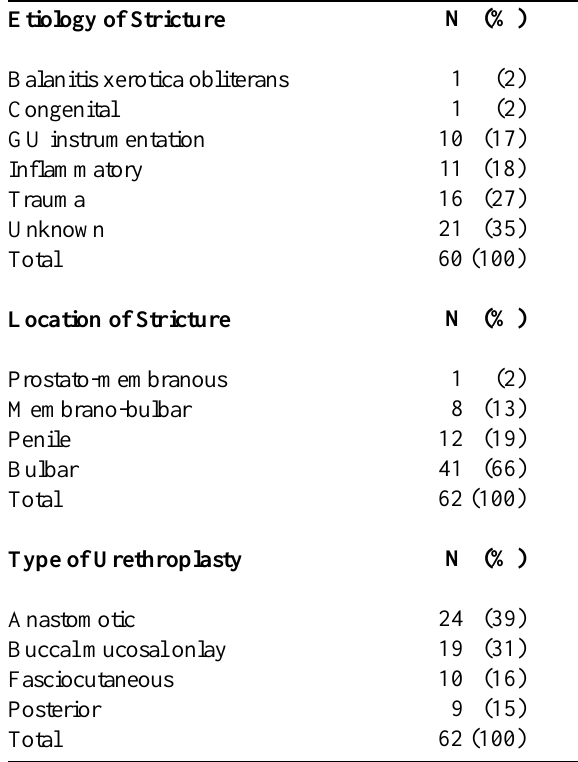
Table 1 – Etiology of urethral strictures, location and type of urethroplasty, overall early and late complications in 60 patients with 62 urethral